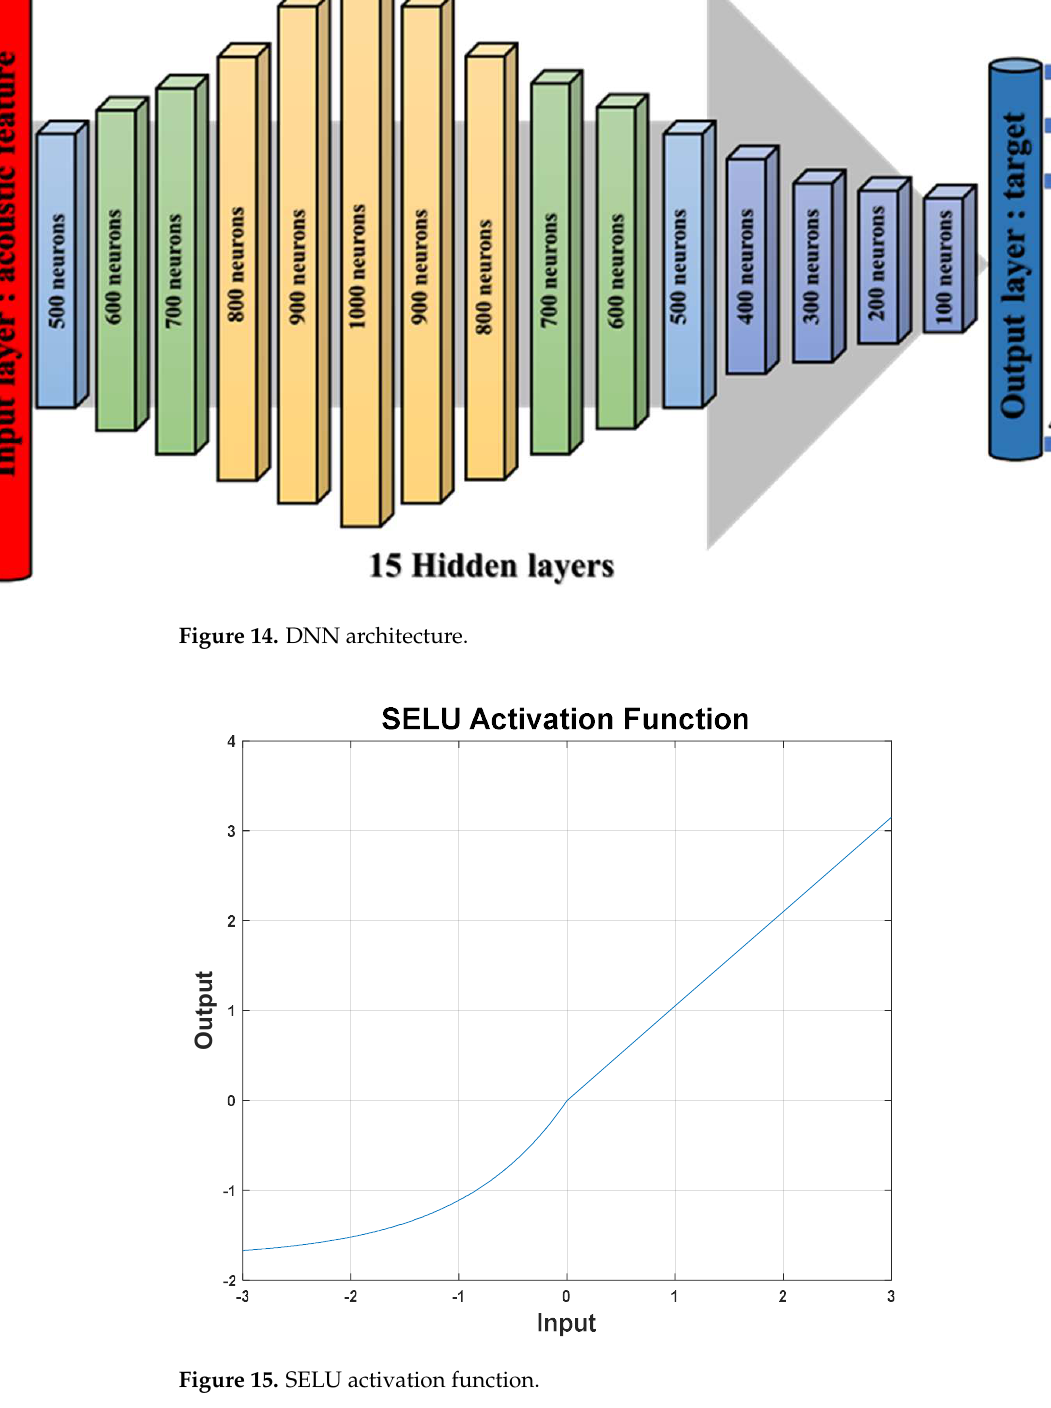
Figure 15. SELU activation function.